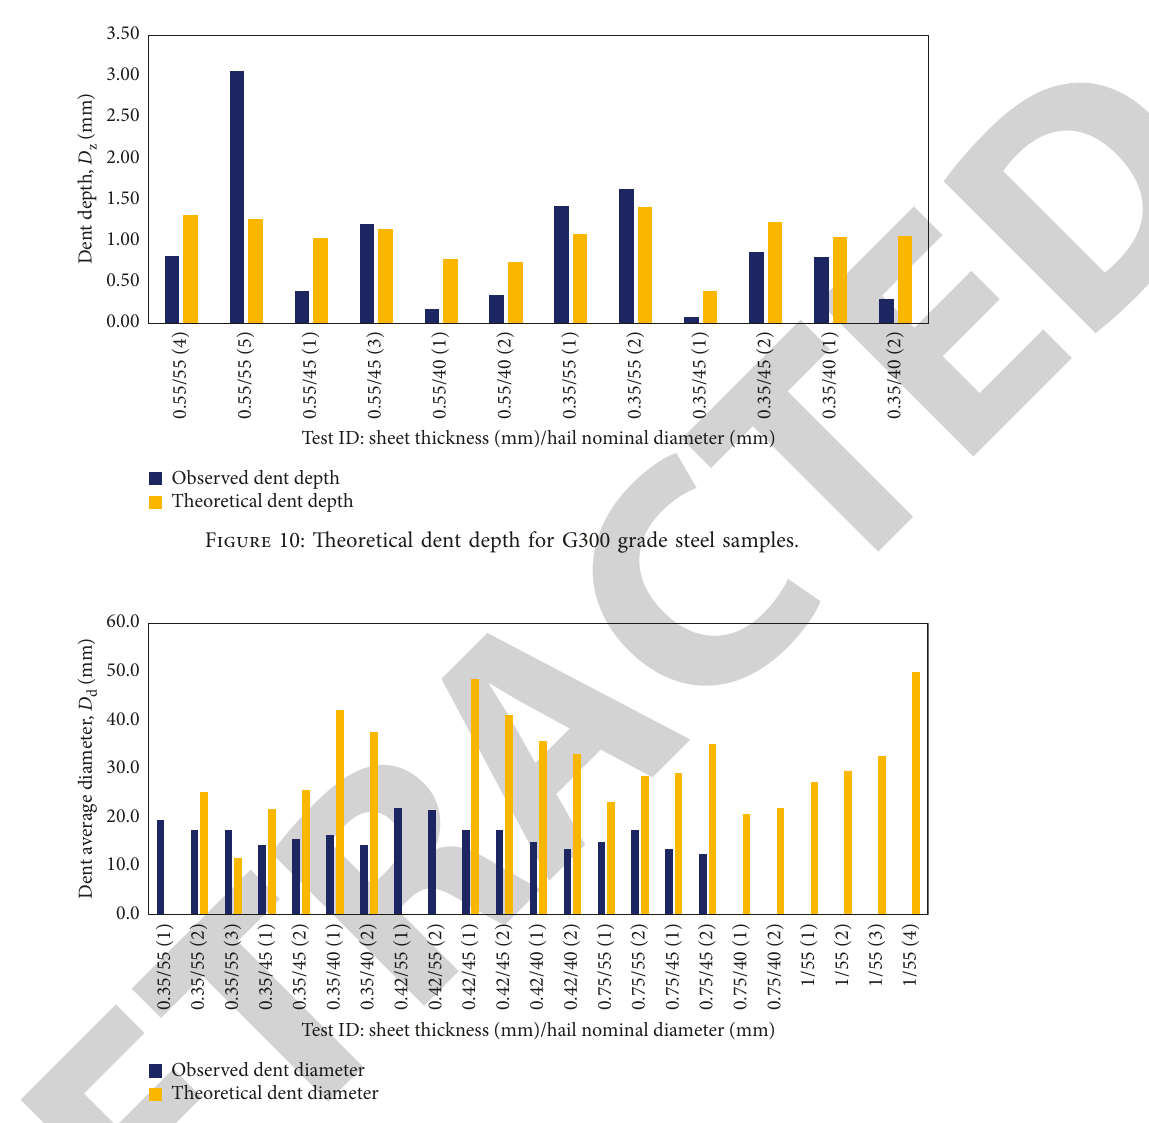
Figure 11: Theoretical dent diameters for G550 grade steel